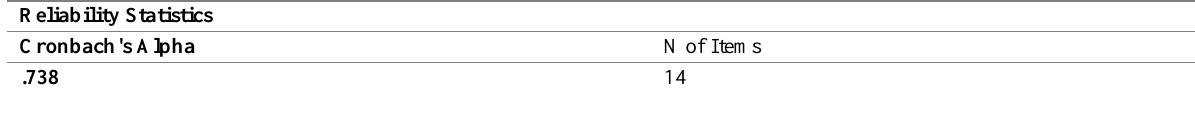
Table 1: Result of Reliability test